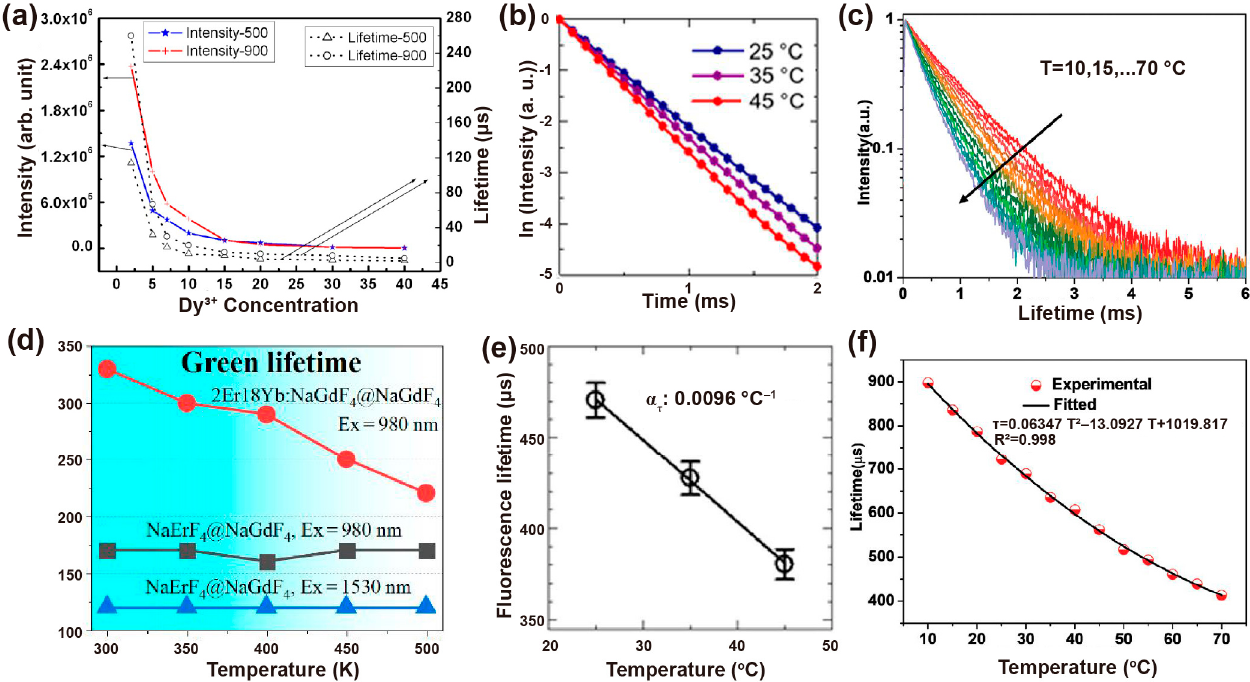
Figure 6. ( a ) Intensity (left) and the corresponding decay lifetime of Dy 3+ at 4 F 9/2 states (right) with the dependent variable of Dy 3+ concentration when excited at 310 nm. Reproduced with permission from [60]. Copyright 2009, AIP Publishing. ( b ) Luminescence decay curves of NaYF 4 :Nd 3+ ,Yb 3+ at different experimental temperatures and ( e ) the corresponding calibration curve of temperature vs. luminescence lifetime. Reproduced with permission from [63]. Copyright 2019, Nature Publishing Group. ( c ) The decay curves of the measured NaYF 4 @NaYF 4 :20%Yb 3+ ,60%Nd 3+ @CaF 2 nanoprobe at various temperatures and ( f ) corresponding nonlinear fitted curves between measured lifetime and temperature ranging from 10 to 70 °C. Reproduced with permission from [66]. Copyright 2020, WILEY-VCH. ( d ) Negative correlation curves of the lifetime of Er 3+ at 4 S 3/2 versus ambient tempera- ture for NaErF 4 @NaGdF 4 and NaErF 4 :18%Yb,2%Er@NaGdF 4 nanoparticles. Reproduced with per- mission from [67]. Copyright 2020, MDPI. 3. Bioapplications With proper surface functionalization, lanthanide-doped nanoparticles possessed good biocompatibility and low toxicity [68]. Additionally, the pulsed laser illumination has a lower thermal effect than continuous-wave laser emission, which was harmful in biological applications [23]. Therefore, lanthanide-doped nanoprobes combined with life- time sensing technology involving time-gated and lifetime coded imaging is widely used in biology and medicine [18]. This review gives a perspective of lifetime-based sensing and imaging in biological applications at molecule, cell, organ and living body levels. 3.1. Ions and Molecules Detection The quantitative detection of targets based on intensity was unreliable due to the inhomogeneous scattering and absorption. Utilizing the lifetime variation of donor and acceptor, lifetime sensing based on the FRET mechanism could monitor ions’ concentra- tion accurately. Zhang et al. integrated the Nd 3+ -doped nanoparticle (energy donor) and MY-1057 (energy acceptor) to detect peroxynitrite (ONOO − ) in the tumor-microenviron- ment based on the lifetime of NIR-II emission. The luminescence lifetime of the nanosen- sor at 1060 nm shortened with the increase in the amount of the surface dye molecules. The energy acceptor MY-1057 was destructed after reacting with reactive nitrogen species (especially ONOO − ), resulting in the lifetime being recovered. Furthermore, the lifetime of the nanosensor would recover from 202 to 303 μ s continuously after ONOO − addition, showing linearity corresponding to ONOO − concentration while independent of the